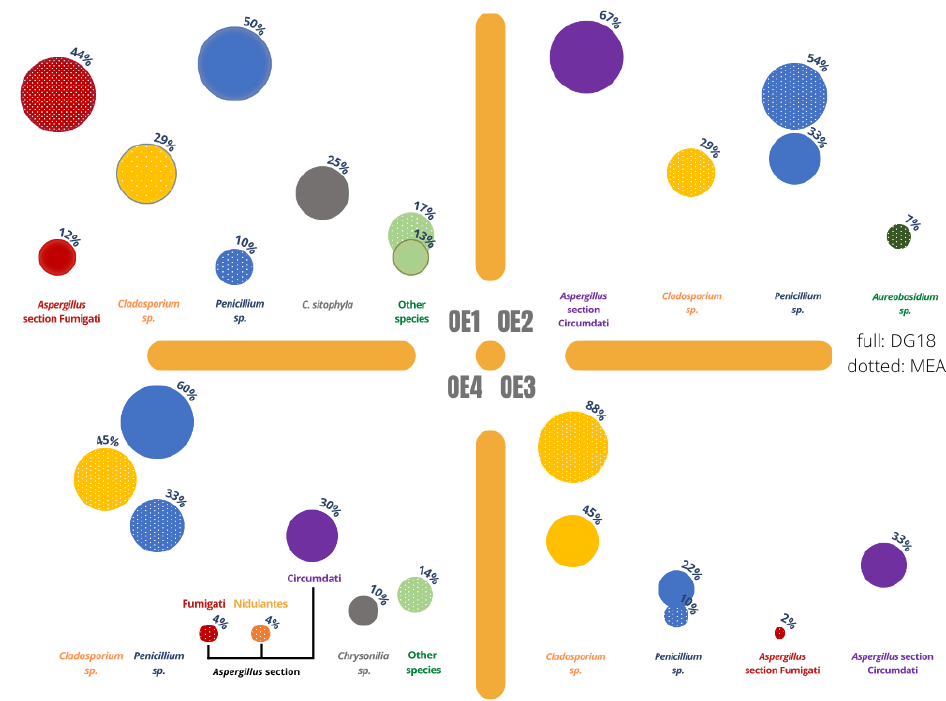
Figure 4. Total fungal counts on MEA and DG18 in samples from different areas (CFU·m −2 ·day −1 ). Boxplot for comparison of fungal contamination in MEA ( A ) and DG18 ( B ) media between sampled areas (excluding the sculpture area (OE2), since it has a single record).